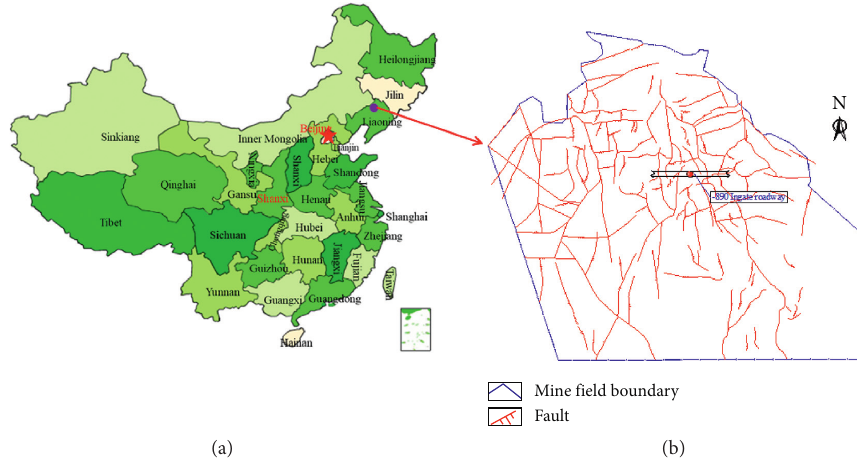
Figure 1: (a) Location of Daqiang Coal Mine, Shen Yang, China. (b) Faults distribution in a minefield.